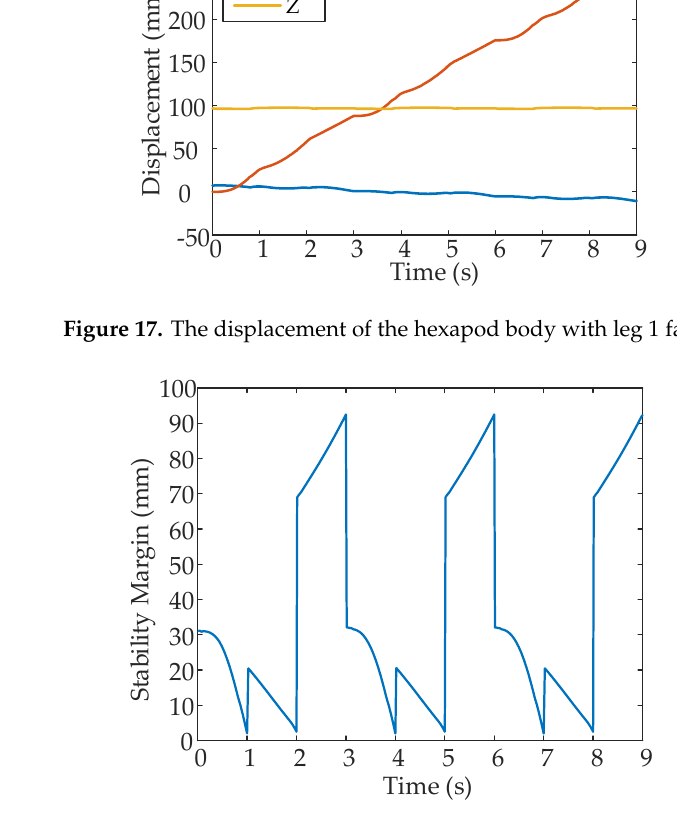
Figure 18. Stability margin variation with leg 1 fault.